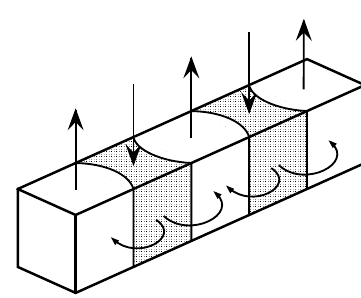
Figure 7. Domain wall motion for initial permeability.